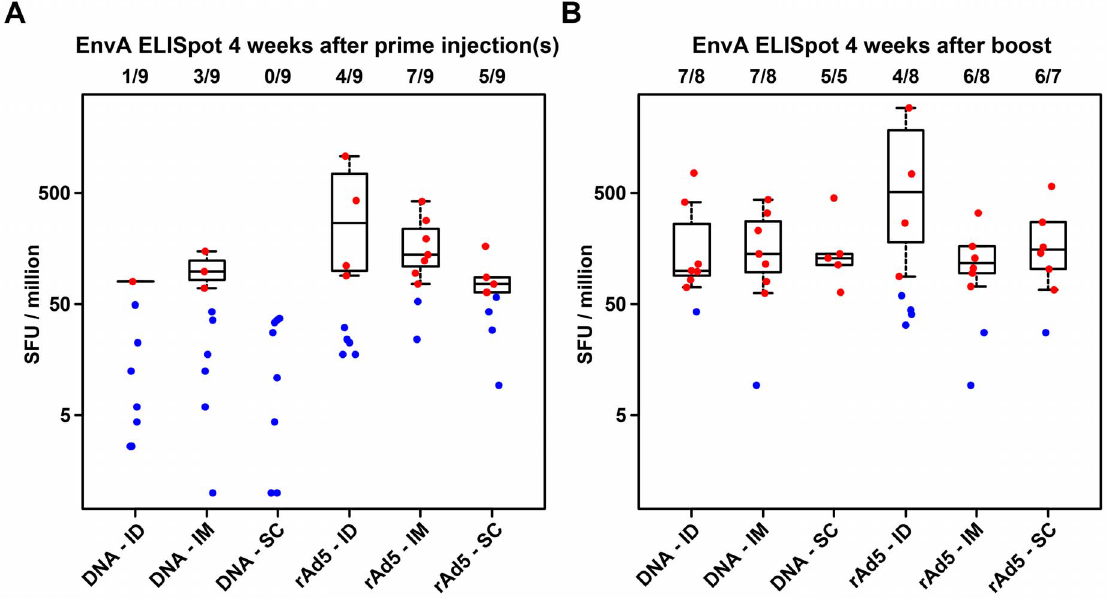
Figure 2. ELISpot responses among the different groups after priming with vaccine and route indicated on X-axis (panel A) and after rAd5 boosting IM (panel B). The numbers above each boxplot represent the fraction of participants in each group with available data at that time point who were judged to be responders using predefined criteria. The responders are represented on the plot with red dots, and are used to construct the boxplots; blue points represent non-responders and are not included in the boxplots. doi:10.1371/journal.pone.0091366.g002 PLOS ONE |